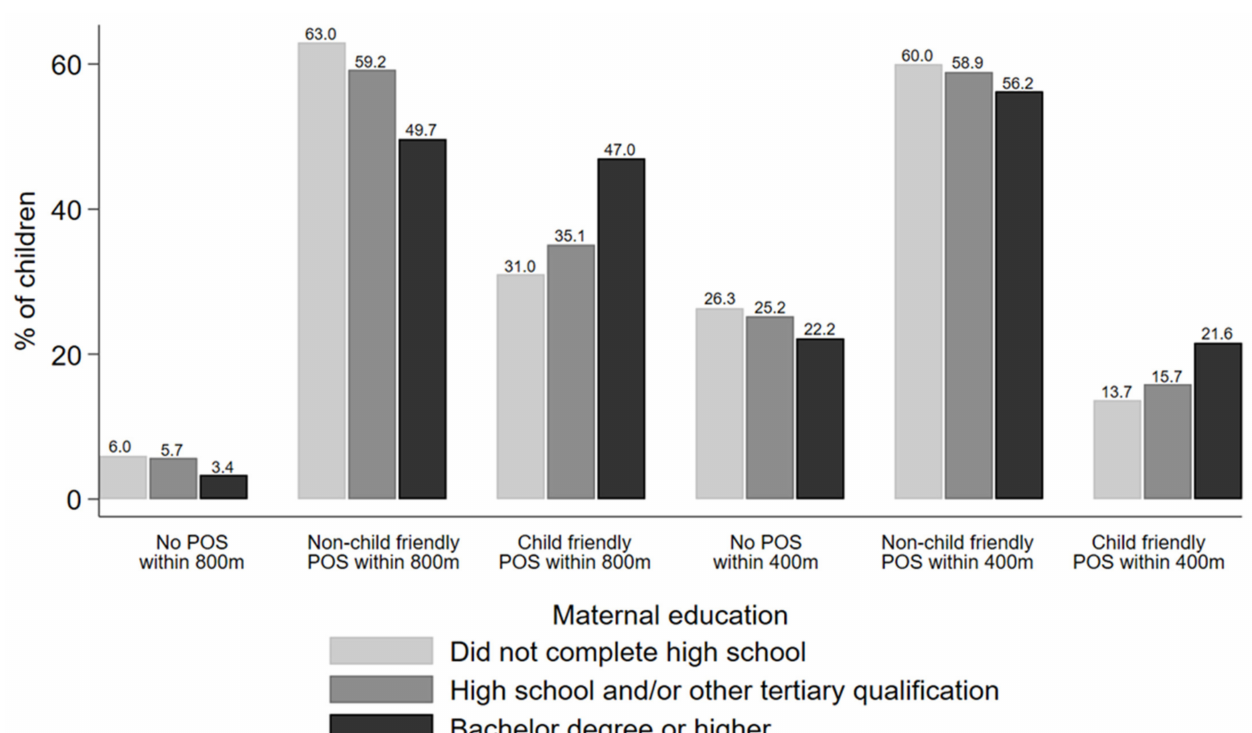
Figure 1. Percentages of children within each maternal education subgroup who have access to public open space within 800 m and 400 m from home along the road network. Children with missing data on maternal education (n = 16,662) not shown. POS: public open space. Child friendly POS defined as having both playground and public toilet nearby; non-child friendly POS defined as those lacking either/both of these child friendly